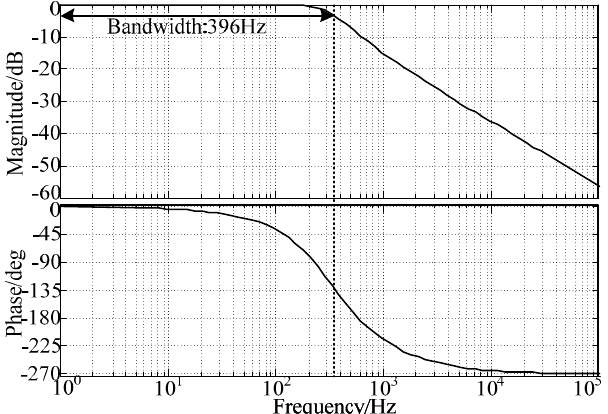
Figure 6. Root locus diagrams with P controller. ( a ) Regardless of coupling; ( b ) Considering coupling.